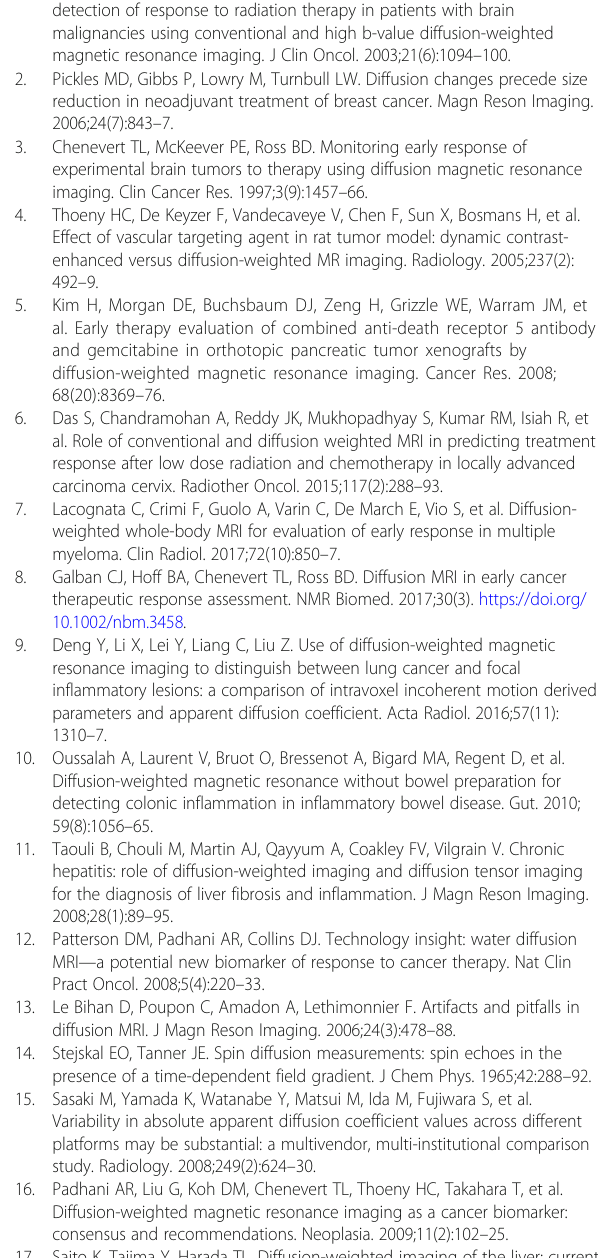
Additional file 1: Immunohistochemic staining of liver parenchyma from tumor-bearing rats 1 – 4 and one healthy rat. (DOCX 2697